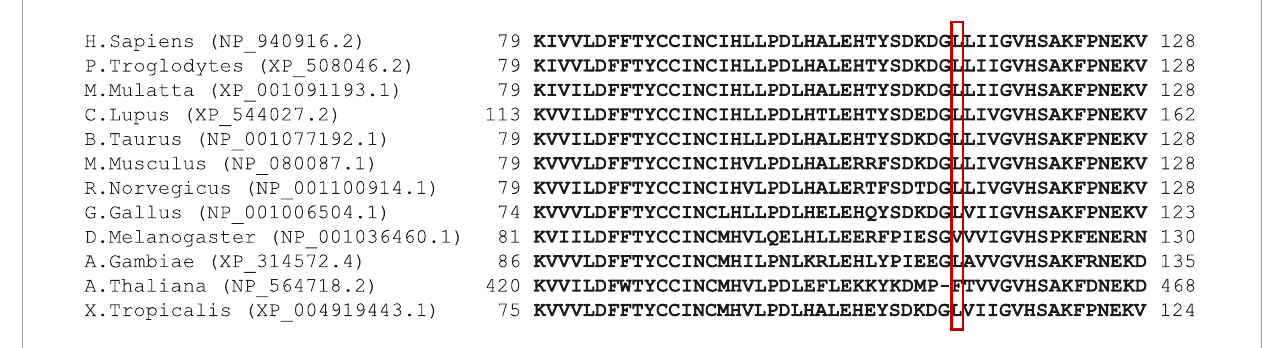
FIGURE2 Multiple sequence misalignment of NHLRC2 spanning aa 79–128. p.L113R has been highlighted with a red box. Generated by MUSCLE (Edgar, 2004) version 3.6 (using option: -maxiters2) (Edgar, 2004).